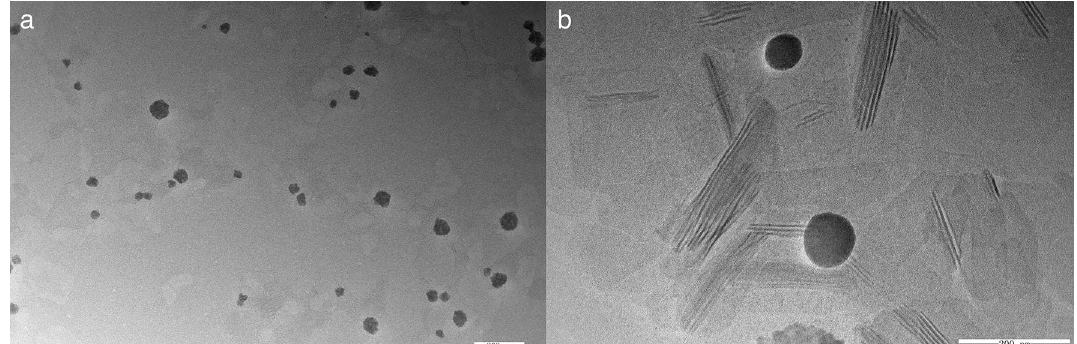
Figure 1. Transmission electron microscopy micrographs of the GenNLCs. ( a ) GenNLCs were monodispersed without obvious aggregation. ( b ) Particles were monodispersed without obvious aggregation, generally in spherical shapes with smooth edge, displaying solid, dense structure. Scale bar: 200